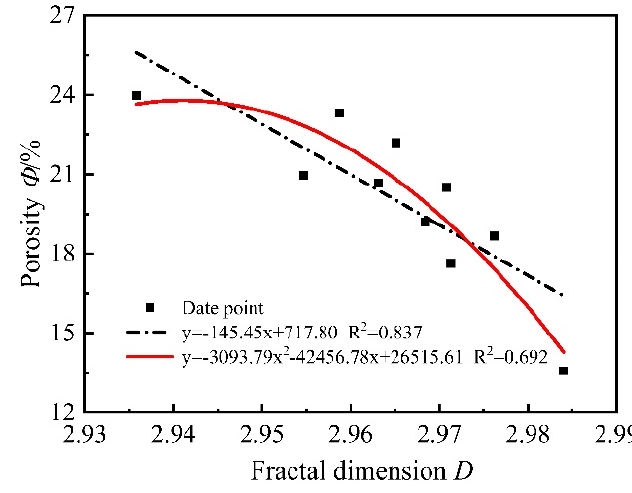
Figure 18. Relationship between porosity and fractal dimension.